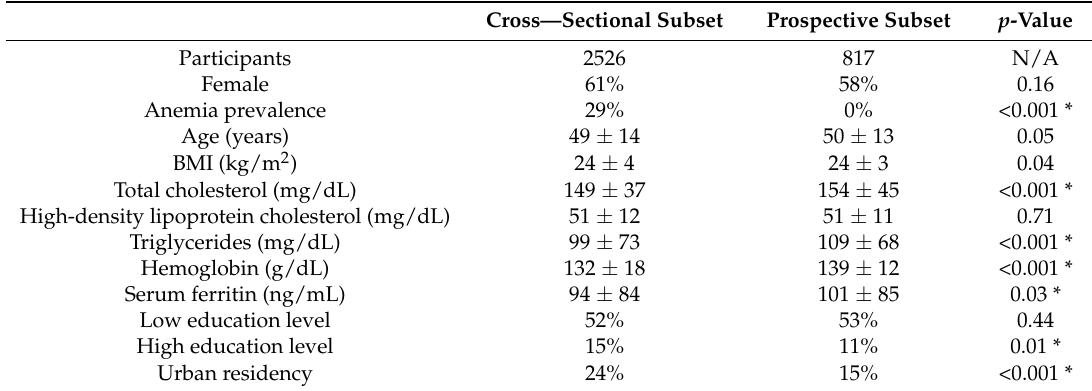
Table 1. Baseline characteristics of the datasets in the cross-sectional analyses (Figure 1B,D) and the prospective analyses (Figure 1H,J).